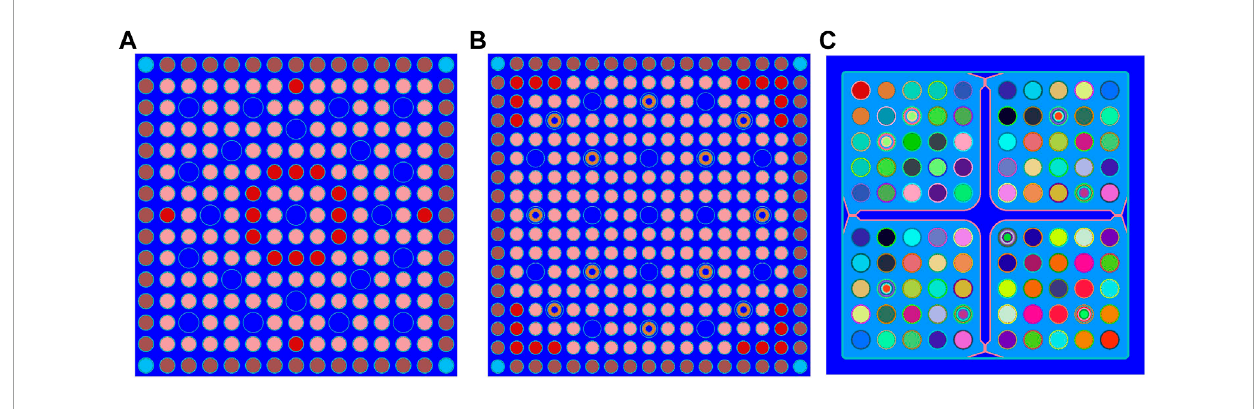
FIGURE 2 Example fuel assembly models used in the calculations. (A) 15x15 PWR Assembly: Ringhals-2 (B) 17x17 PWR Assembly: Ringhals-3 (C) SVEA-100 Assembly: